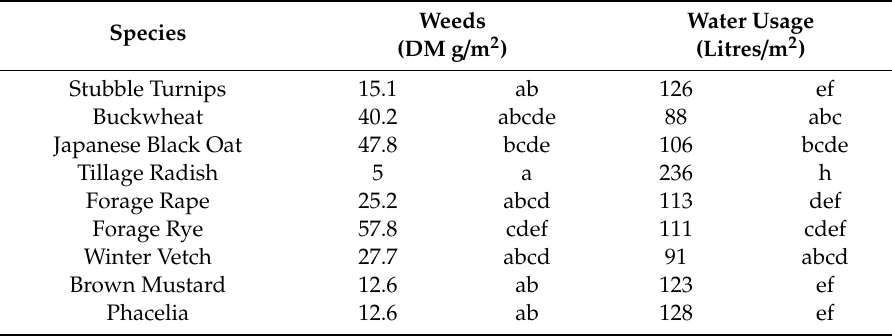
Table A3. Species mean values of weeds, water